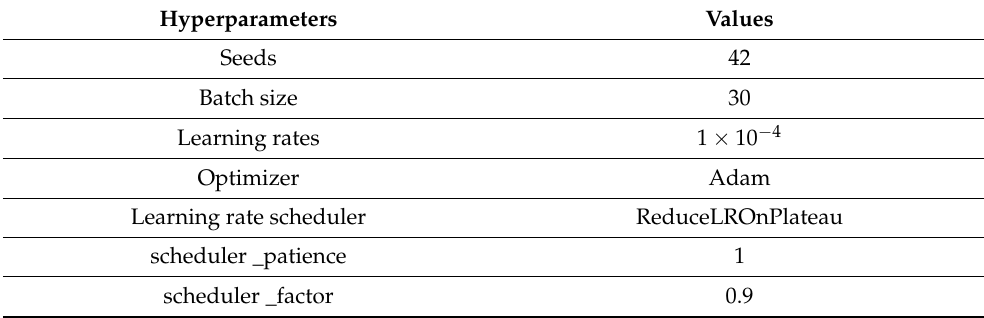
Table 3. Hyperparameters used in MSE loss training stage.